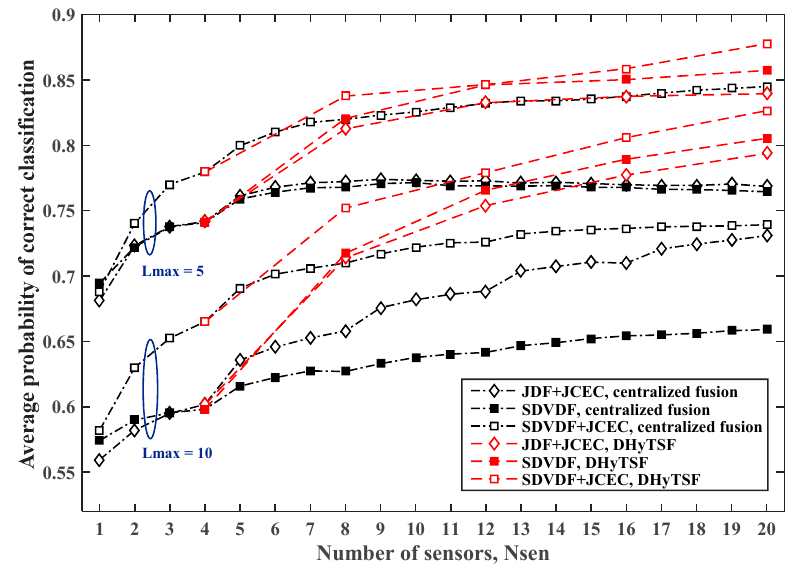
Figure 6. The estimated P CC , avg value for the centralized and distributed cooperative MC in SNS1, for N S = 500 and di ff erent dispersive environments ( L max = 5 and L max = 10